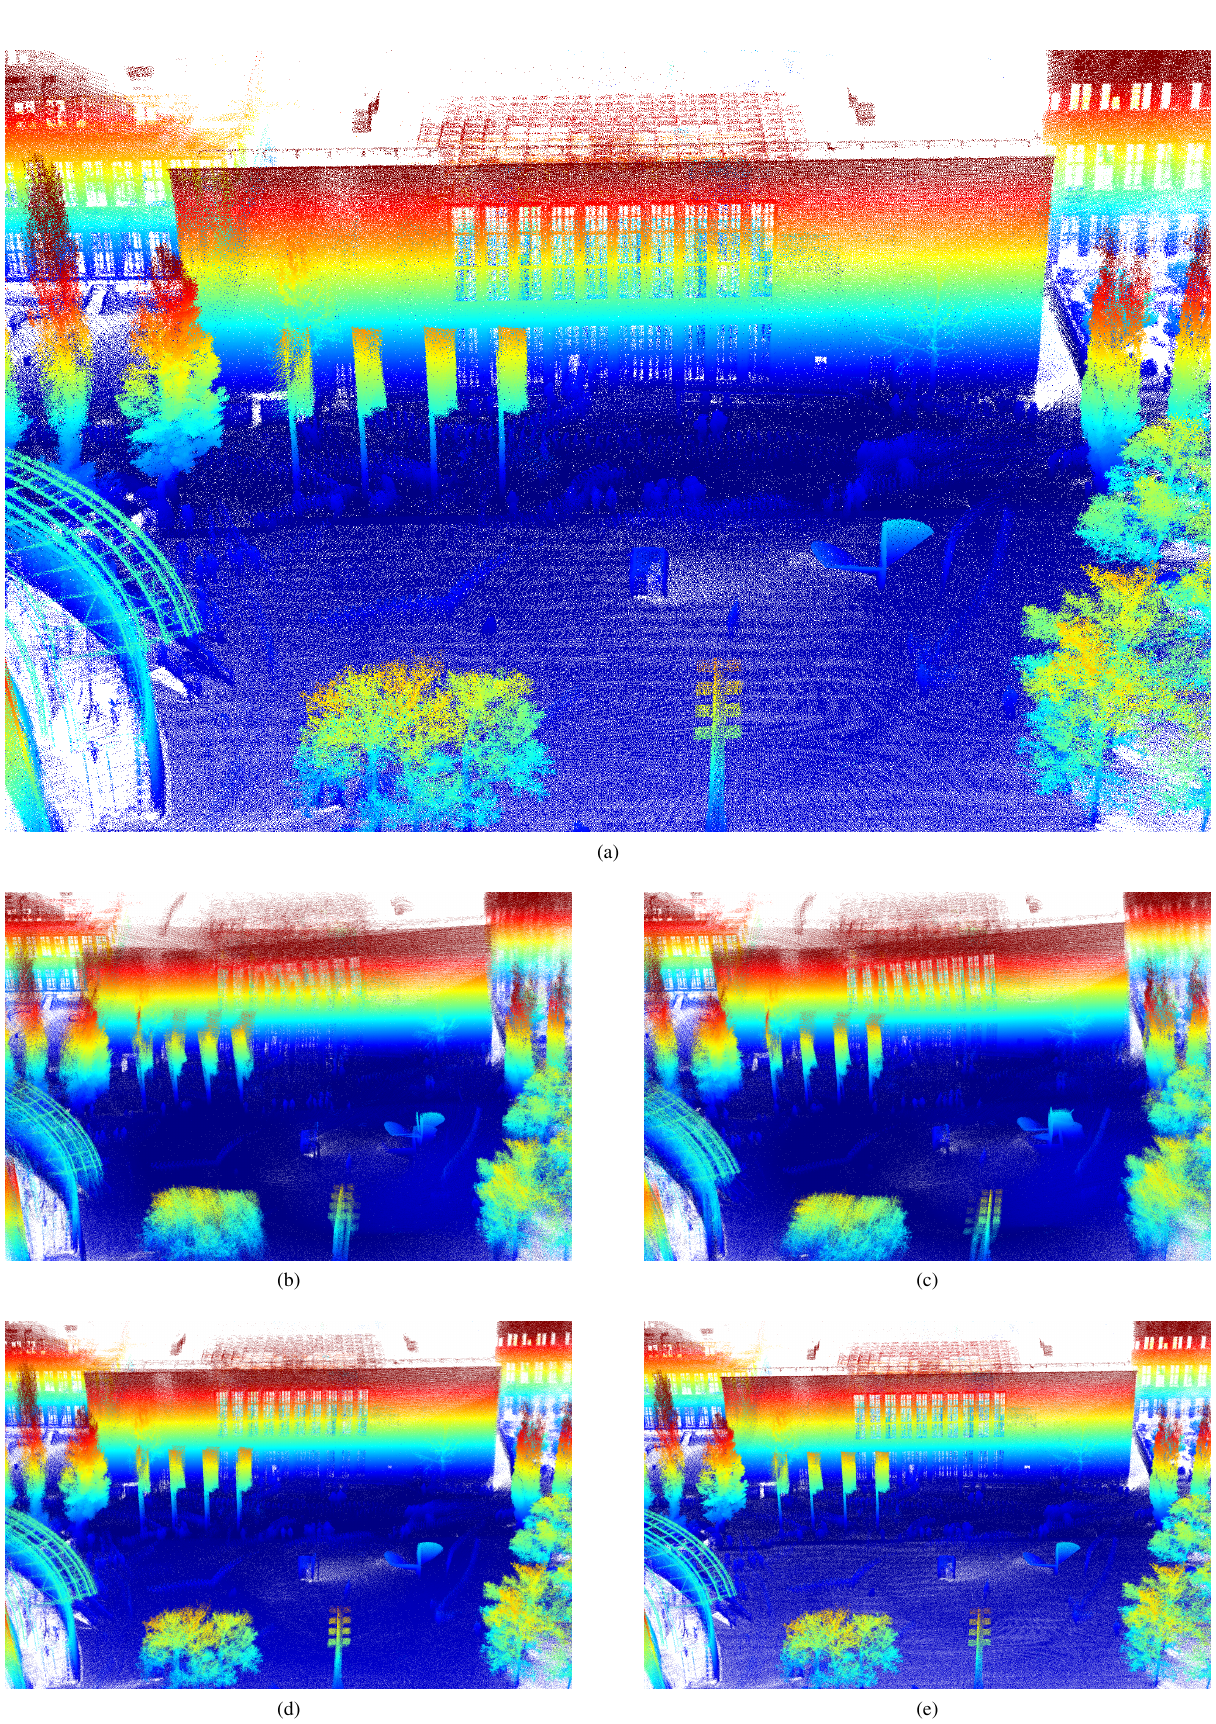
Figure 2. Point clouds computed after calibration with different trajectories. (a) Ground truth calibration, (b) uni-directional trajectory, (c) ortho-directional trajectory, (d) bi-directional trajectory, (e) multi-directional